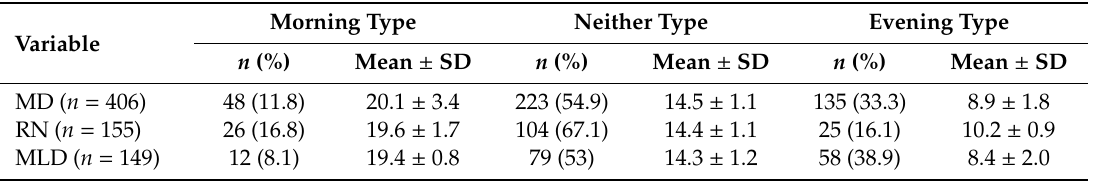
Table 4. Distribution and descriptive statistics of morningness-eveningness orientation (rMEQ) according to gender and within the di ff erent majors ( n =